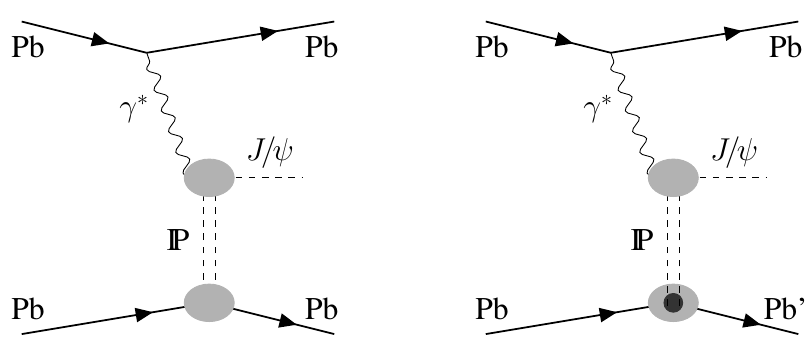
Figure 1 . Illustration of the (left) coherent scatter with the lead nucleus and (right) incoherent interaction with a single nucleon leading to exclusive production of J/ψ mesons in ultraperipheral heavy-ion collisions. The symbol Pb’ represents any final state for the nucleus inelastic scattering in the incoherent